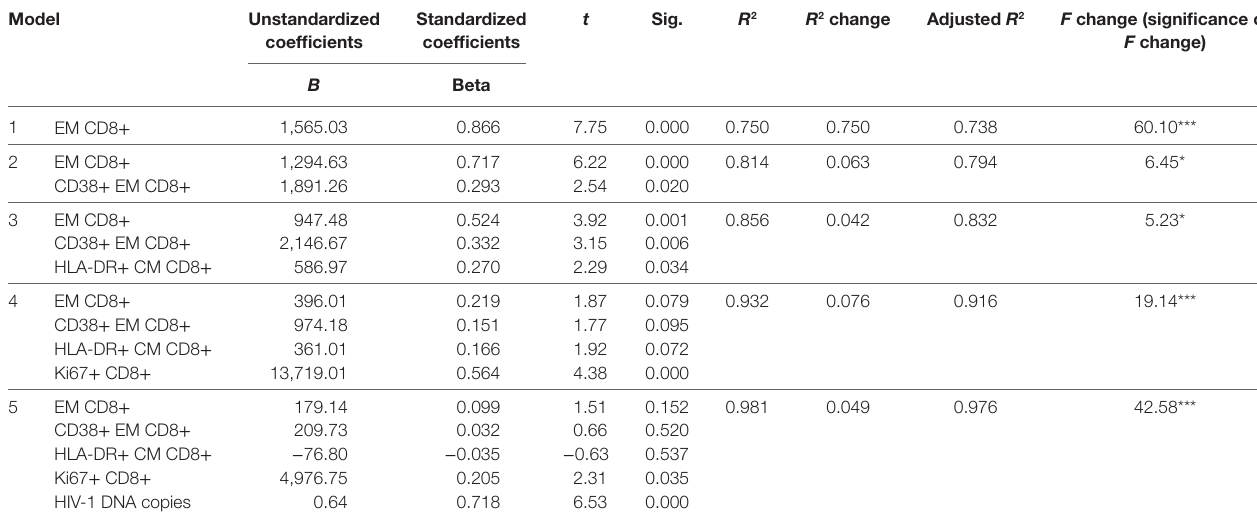
TaBle 3 | Stepwise multivariate linear regression analysis between changes in HIV-1 DNA copies [baseline minus 1 month from vaccination (dependent variable)] and clinical and immunological parameters (independent variables).